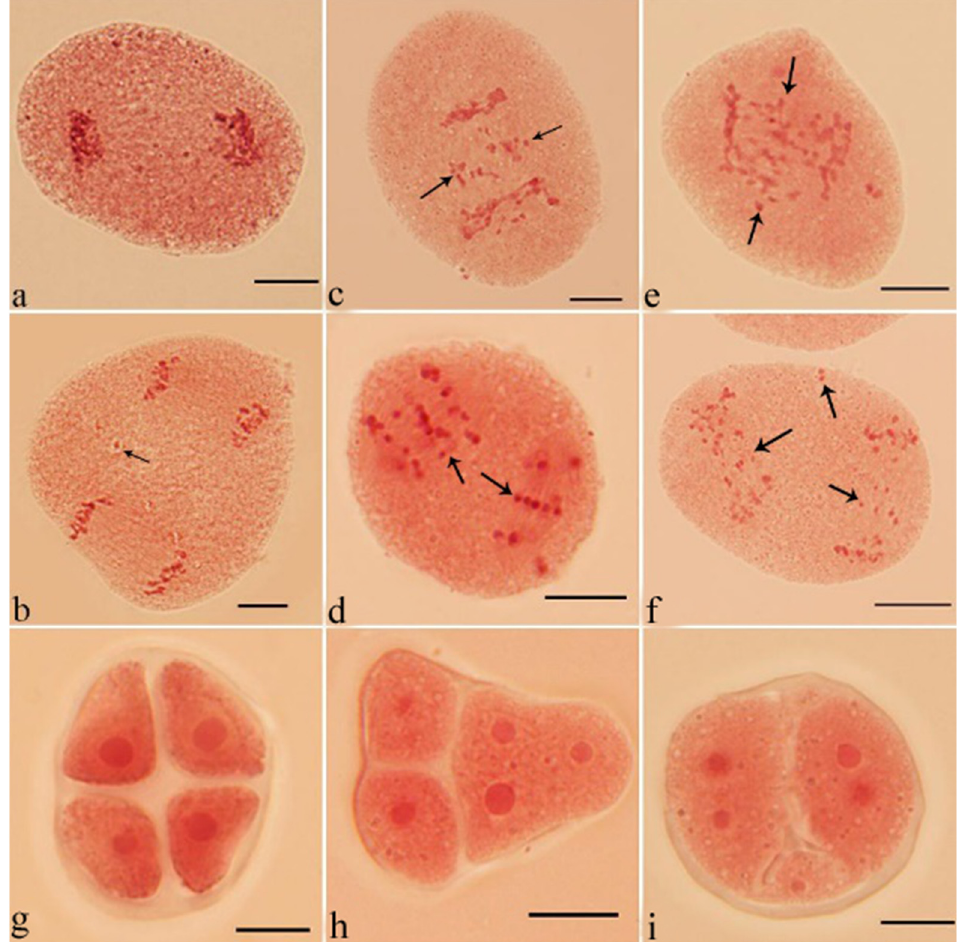
Figure 4. High temperature-induced lagging chromosomes and aberrant cytokinesis during the microsporogenesis of P. canescens . ( a ) Anaphase I in a control PMC. ( b ) Lagging chromosomes (arrow) at anaphase II in a control PMC. ( c ) Lagging chromosomes (arrow) in anaphase I derived from a PMC previously exposed to 38 °C for 3 h. ( d ) Lagging chromosomes (arrow) in anaphase II derived from a PMC previously exposed to 38 °C for 3 h. ( e ) Lagging chromosomes (arrow) in anaphase I derived from a PMC previously exposed to 38 °C for 6 h. ( f ) Lagging chromosomes (arrow) in anaphase II derived from a PMC previously exposed to 38 °C for 6 h.( g ) Normal tetrad in a control PMC. ( h ) Polyad derived from a PMC previously exposed to 38 °C for 3 h. ( i ) Polyad with unbalanced cytokinesis derived from a PMC previously exposed to 38 °C for 6 h. Bars = 10 μ m.